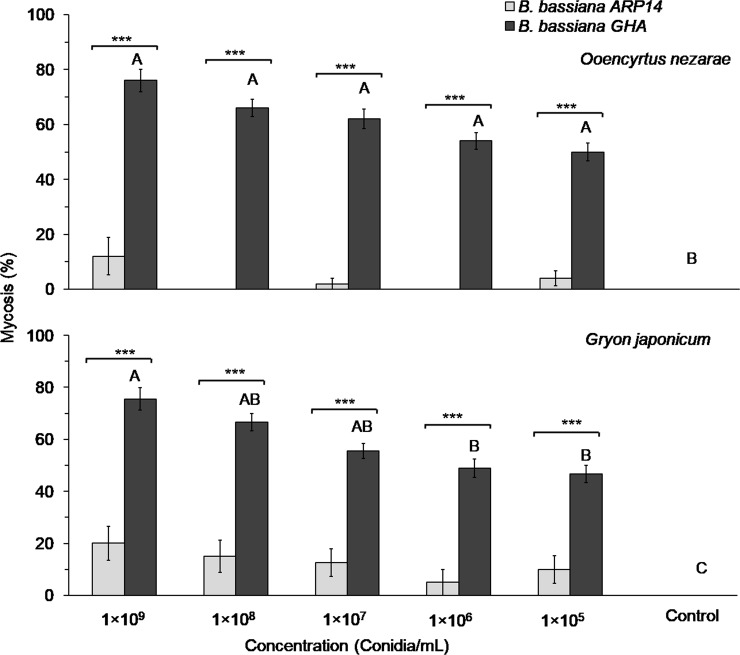
Mycosis rate of the Beauveria bassiana strains ARP14 and GHA in adults of Ooencyrtus nezarae and Gryon japonicum when exposed in conidia-coated glass-vials for 12 h.Mean mycosis rates followed same letter are not significantly different among the different concentrations in Beauveria bassiana ARP14 (small letters) or GHA (capital letters) (χ2, P > 0.05). Significance of differences between mycosis rates within conidial concentrations, between the ARP14 and GHA strains are denoted as follows: * 0.01<P ≤ 0.05, ** 0.001<P ≤ 0.01, ***P ≤ 0.001 and ns indicates non-significance.